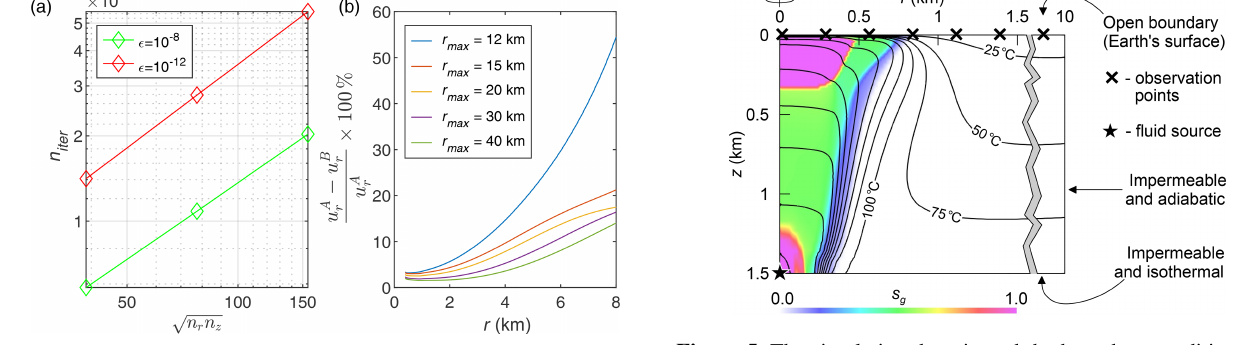
Figure 4. Average number of pseudo-transient iterations n iter re- quired to satisfy different convergence criteria (cid:15) (a) and relative de- viation of the radial component of displacements calculated with method B ( u B r ) from those calculated using method A ( u A r ) for var- ious grid extension factors (b) .